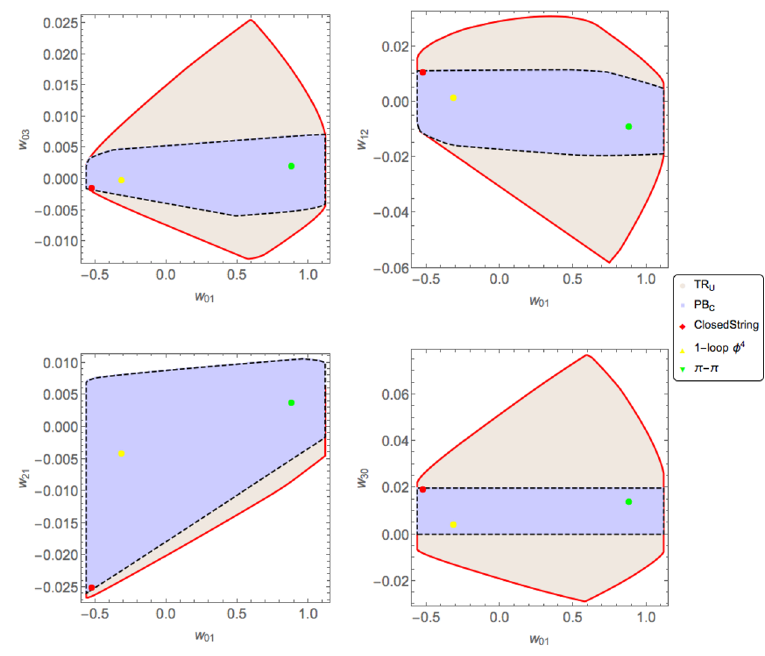
Figure 14. The comparison of the regions obtained for w 03 , w 21 and w 12 with w 30 . n = 4